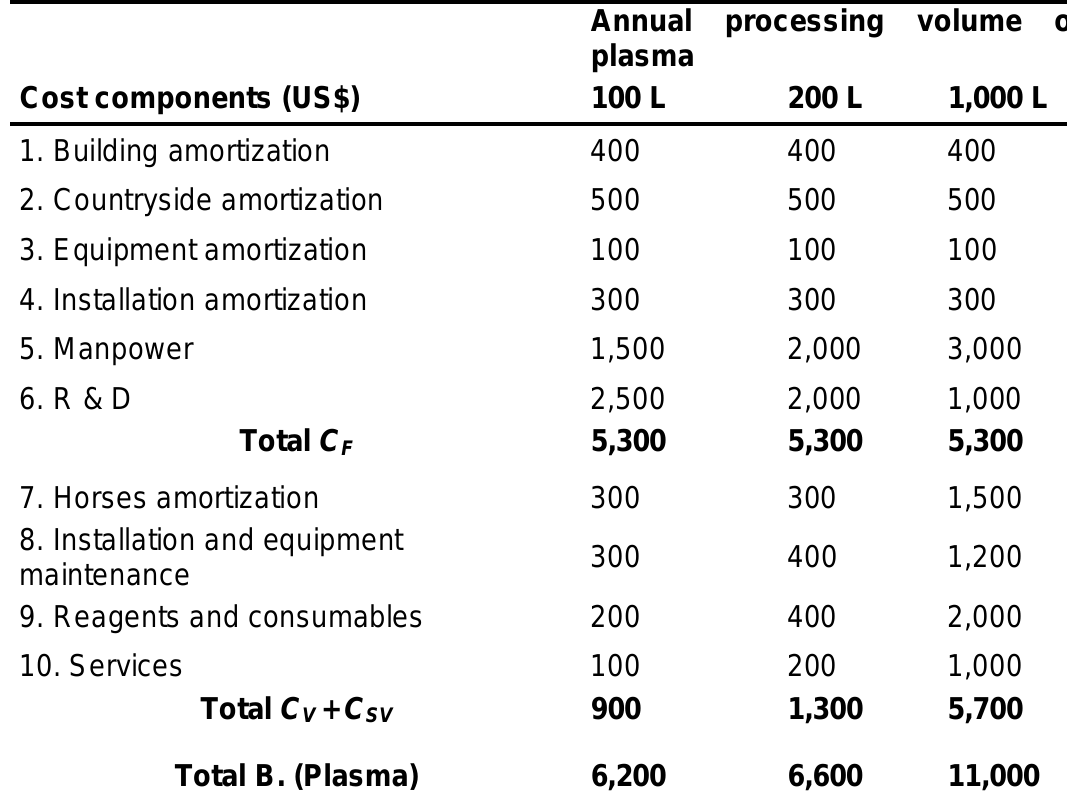
Table 3: Costs associated to the second stage of antivenom production: B. Hyperimmune plasma